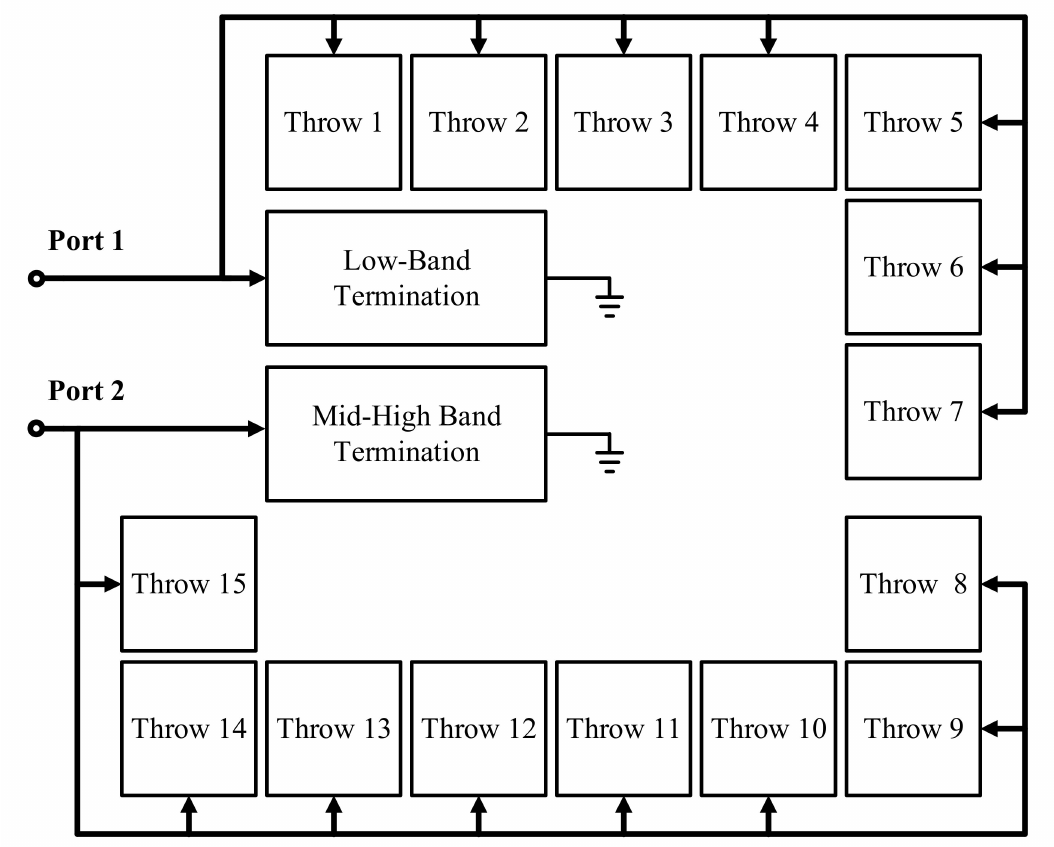
Figure 2. The top RF building block of the proposed DP15T ASM with termination